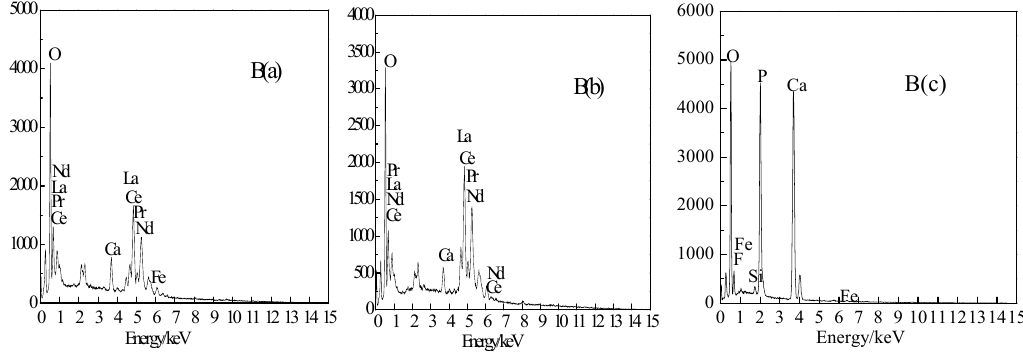
Figure 3. SEM-EDS spectrum of the unroasted sample and roasted sample (( A ) unroasted sample; ( B ) roasted sample for 750 °C at 60 min).